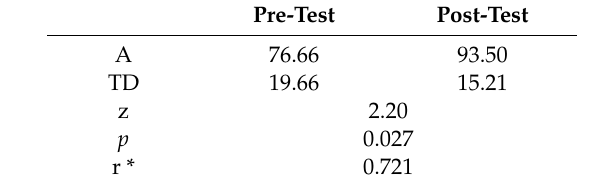
Table 5. Average (A), typical deviations (TD), Wilcoxon test results (Z), significance ( p ), and dMR value (r) of the total number of students in the pre-test and post-test in the Global Emotional Intelligence Test. Pre-Test